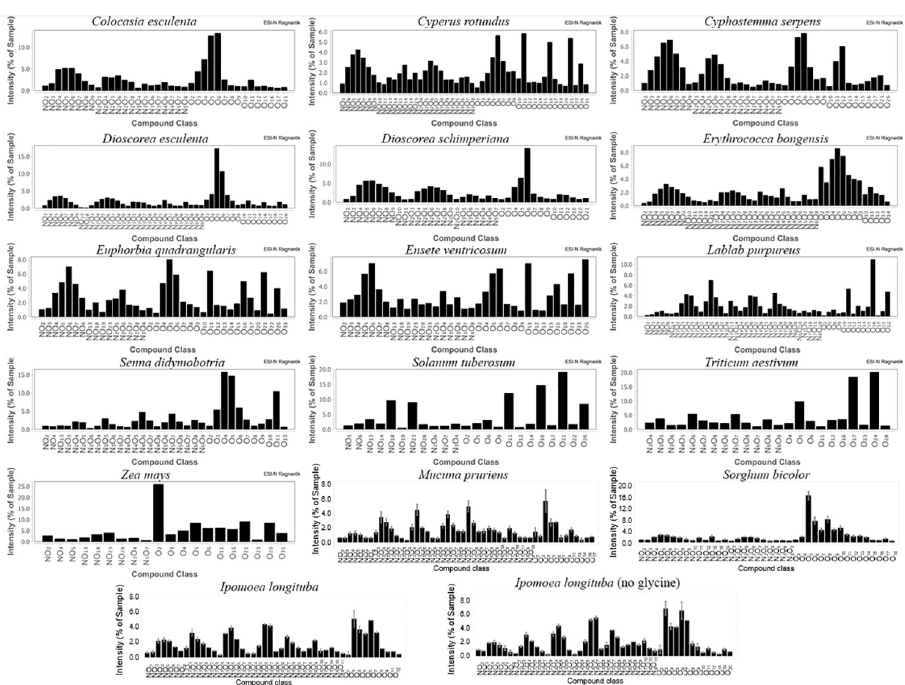
Fig 2. Compound class distribution of water-soluble reaction products (melanoidins). Reaction of glycine and starch from the taxa listed in Table 1 (150˚C, 24 h). FTICR-MS through electrospray ionization in negative ion mode. Controls in triplicate, with deviation bars: Mucuna pruriens , Sorghum bicolor , and Ipomoea longituba